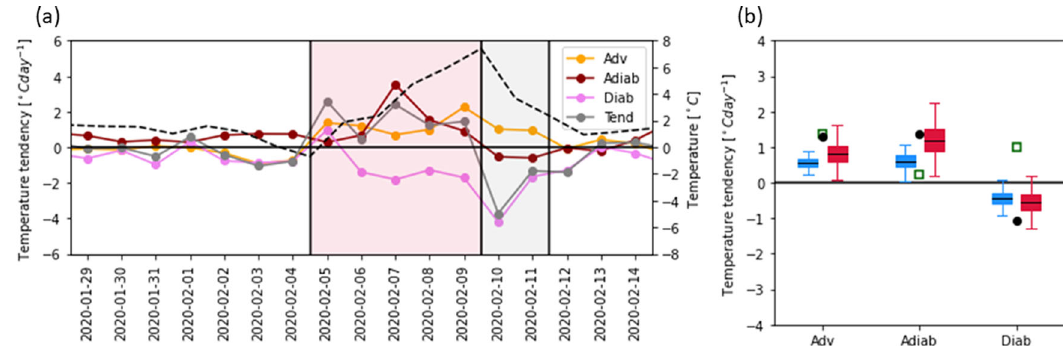
Fig. 5 Physical processes contributing to the 6 – 11 February 2020 heatwave. a Evolution of the observed AP temperature tendency at 975 hPa ( Tend ; in °C day − 1 ). The dashed gray line represents the mean AP absolute temperature at 975 hPa. Pink and grey areas indicate the warming ( Tend > 0) and cooling ( Tend < 0) phases of the 2020 AP heatwave, respectively. b Distributions of the mean AP temperature tendency (in °C day − 1 ) for each contributing term over the warming period (5 – 9 February 2020) of the 2020 AP heatwave, as reconstructed from past (1950 – 1984, blue whiskers) and recent (1985 – 2019, red whiskers) fl ow analogs. The contributing terms include horizontal temperature advection ( Adv ), adiabatic warming ( Adiab ) and diabatic heating ( Diab ). Black dots indicate the observed mean values for 5 – 9 February 2020, with green squares corresponding to the escalation phase (5 February 2020). Boxers and whiskers follow the same layout as in Fig. 4. Data source: